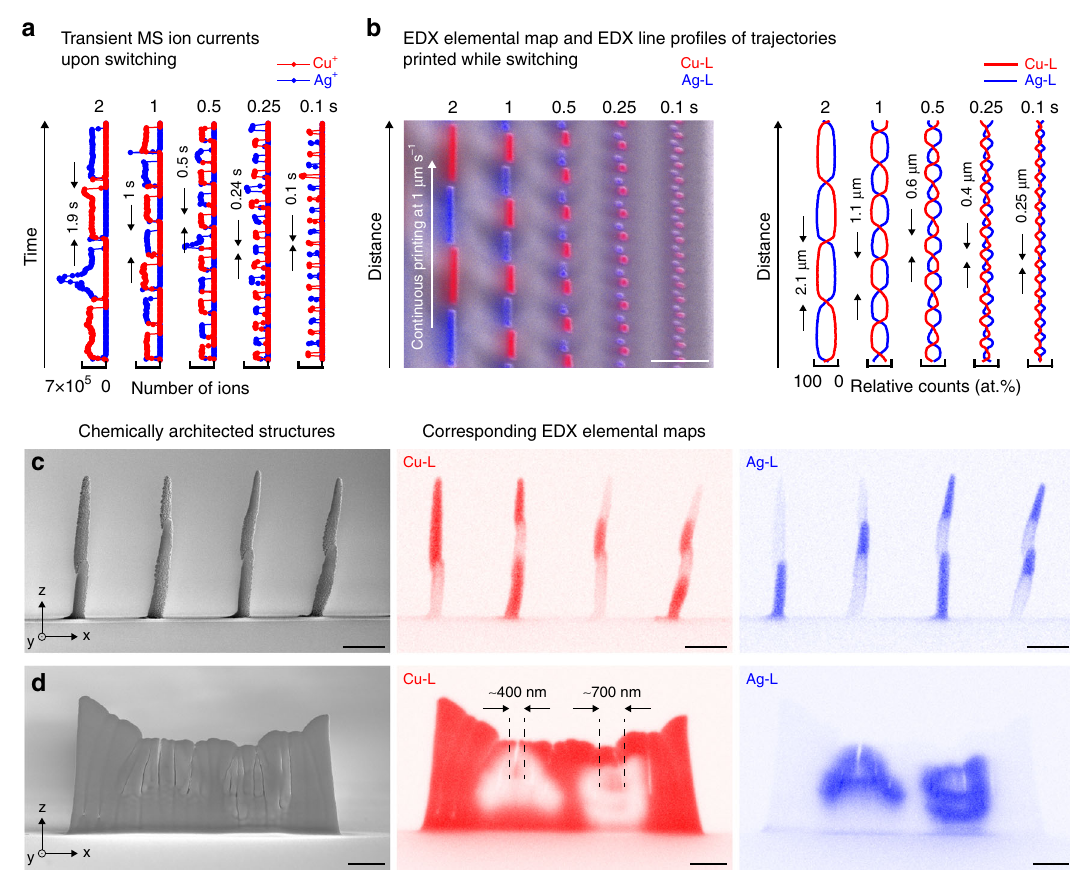
Fig. 2 Additive control of the chemical architecture with a single nozzle. a , b Fast switching between two metals printed from a two-channel nozzle. a Summed mass spectrometry (MS) ion currents of Cu + (red) and Ag + (blue) cations ejected upon switching the anodic voltage between a Cu and a Ag electrode at different intervals. Switching between two ejected ion species is highly selective. b Overlaid SE micrograph and EDX elemental map of trajectories printed with the same switching pro fi le as in ( a ) (Cu-L signal, red, and Ag-L signal, blue). The corresponding EDX line pro fi les show that the switching between Cu and Ag is resolved up to the smallest pulse width. Scale bar: 2 μ m. c , d Examples of chemically heterogeneous structures printed using a single nozzle. c Sequence of pillars with different numbers of Cu and Ag modulation periods. Scale bars: 1 μ m. d Out-of-plane Cu wall with the letters ‘ Ag ’ embedded in silver, printed with a continuous layer-by-layer printing mode (Supplementary Movie 1). Scale bars: 1 μ m. For printing